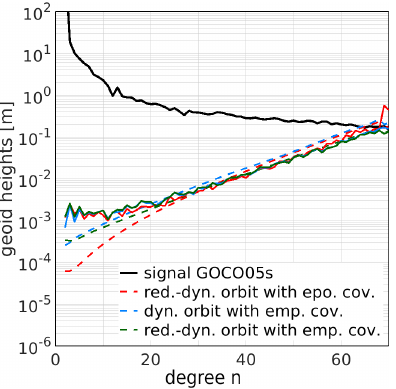
Figure 10. GRACE GPS-only gravity field solution for April 2007. Empirical covariances based on the observation residuals are intro- duced in the gravity field determination process. These covariances are determined as a mean function over one month and include cor- relations over 50min.